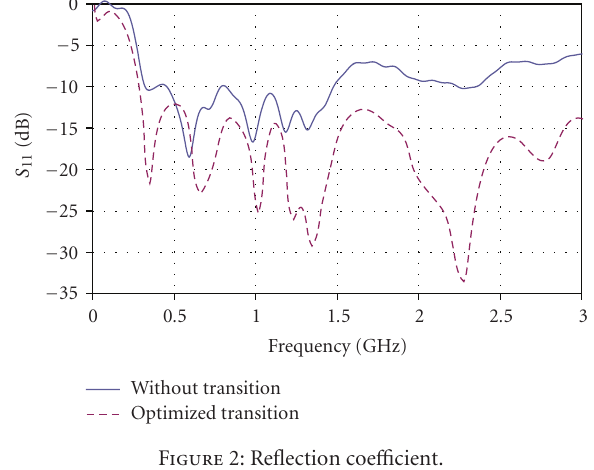
Figure 2: Reflection coe ffi cient.